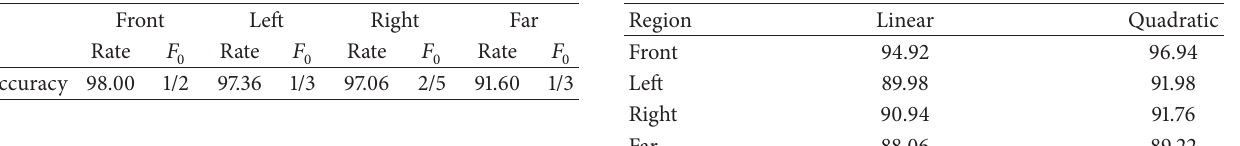
Table 4: Performance of gradient-based descriptor using linear and quadratic Bayesian